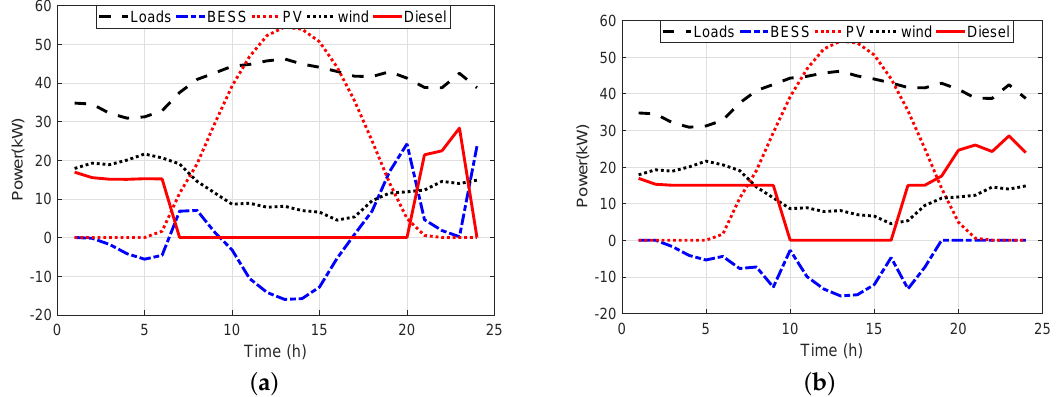
Figure 8. Power schedule of the hybrid system studied in simulation 2 ( a ) the DP approach; ( b ) the rule-based method.